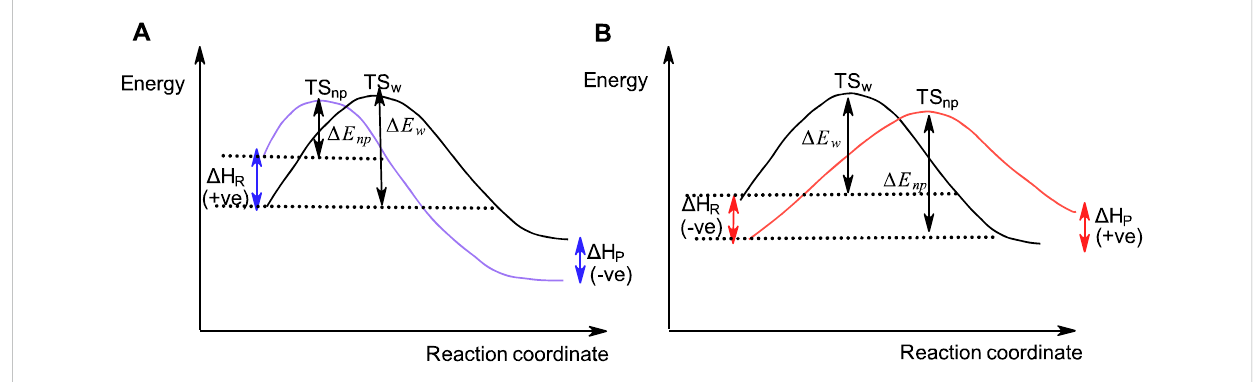
FIGURE 10 A hypothetical reaction coordinate diagram showing qualitatively the S N 2-type reactions in water and a less polar organic solvent involving an anionic nucleophile with (A) a carbon-based substrate, and (B) aphosphinate ester substrate. In (A) , the initial state is destabilized inthe less polar solvent ( Δ H R is positive) to result in an earlier TS and faster reaction ( Δ E np < Δ E w ) in this solvent than in water. In (B) , the initial state is stabilized in the less polar solvent ( Δ H R is negative) to result in a later TS and a slower reaction ( Δ E np > Δ E w ) when compared with the rate in water.